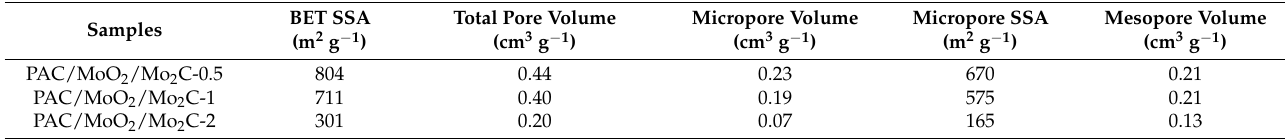
Figure 6. ( a ) N 2 absorption-desorption isotherms, ( b ) pore size distribution of the PAC/MoO 2 /Mo 2 C- 0.5, PAC/MoO 2 /Mo 2 C-1 and PAC/MoO 2 /Mo 2 C-2. Table 2. Textural properties of the PAC/MoO 2 /Mo 2 C ternary composites.